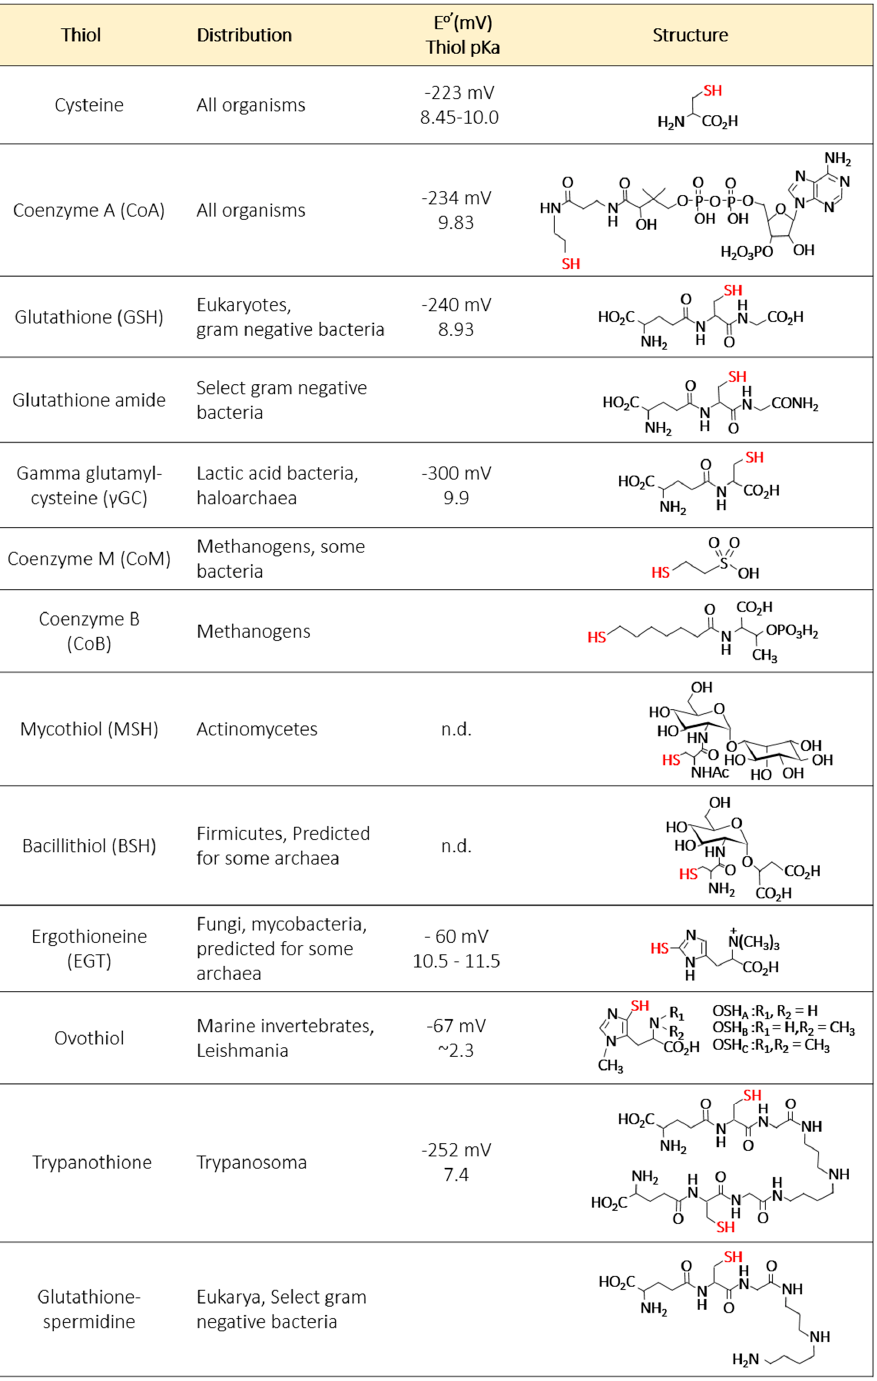
Figure 1. The chemistry of low molecular weight (LMW) thiols and their distribution among phylogenetic